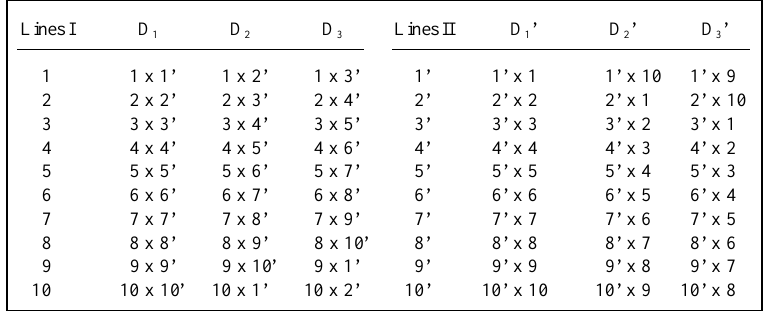
Table IV - Schematic presentation of the diagonals of Table I rearranged according to the source population (I and II). Lines I